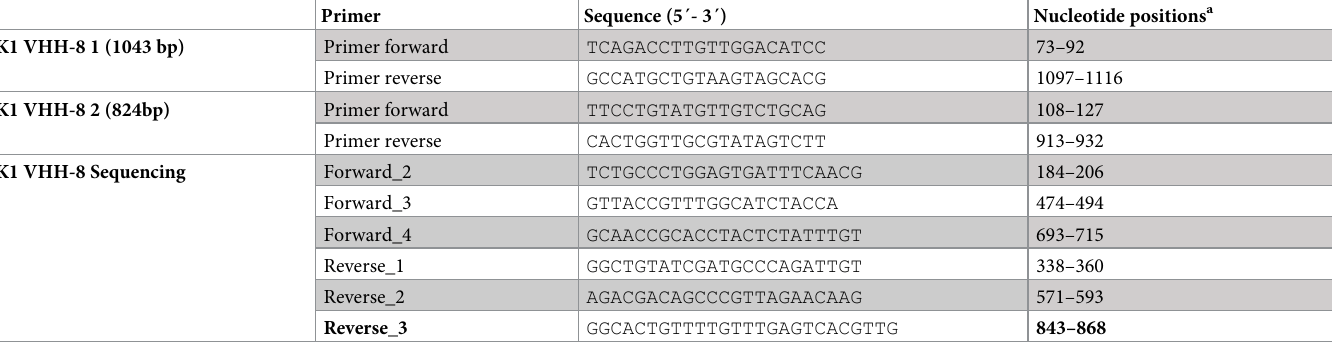
Table 1. Primers used for nested PCR and